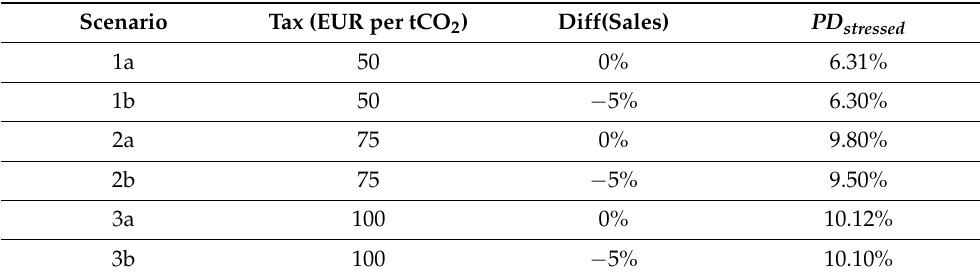
Table 4. Scenario for stress tests.